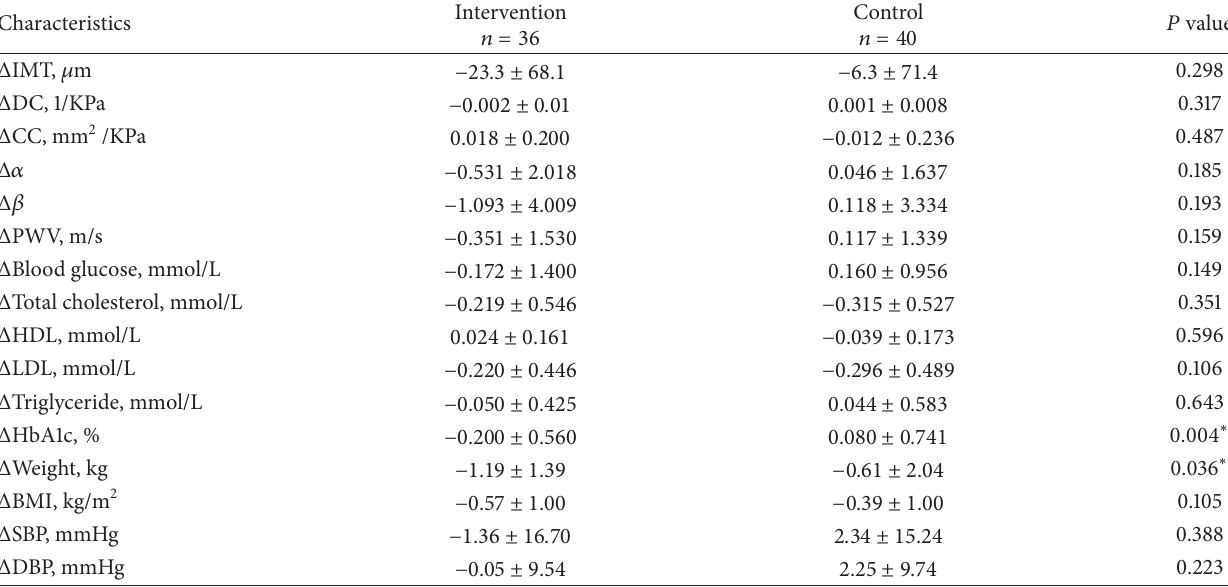
Table 3: Change of characteristics of subjects from baseline to follow-up assessments in the intervention and control groups.